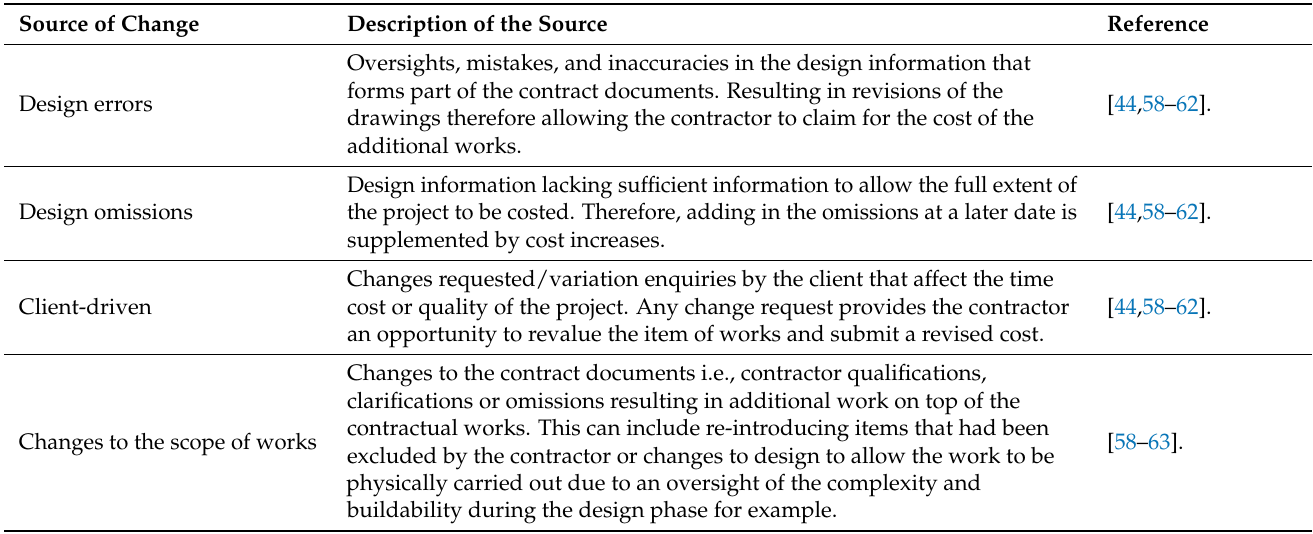
Table 1. Sources of change during the construction